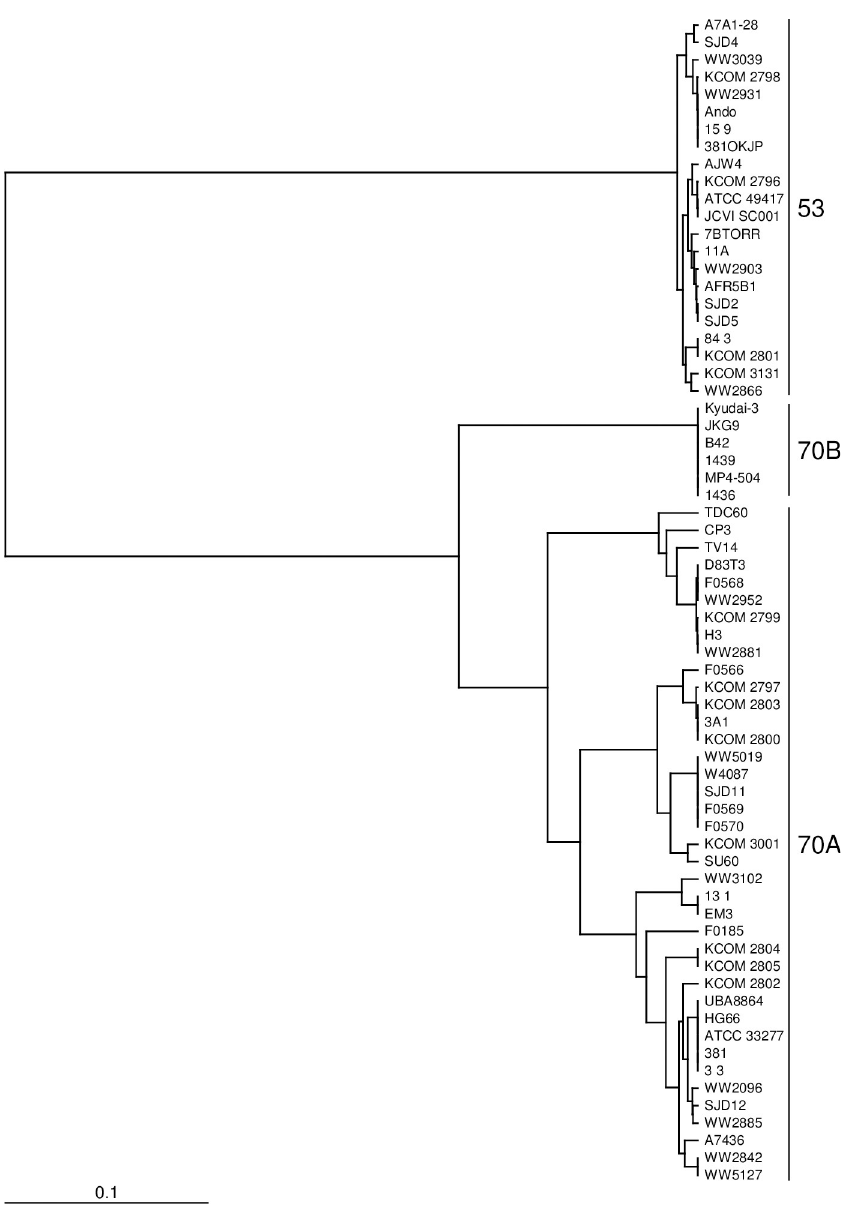
Fig 2. Phylogenetic tree of the mfa1 gene. A phylogenetic tree was constructed with TreeView X through a multiple sequence alignment analysis using Clustal O . The mfa1 gene is primarily classified into genotypes 53 and 70. Additionally, genotype 70 forms two clusters, called genotypes 70A and